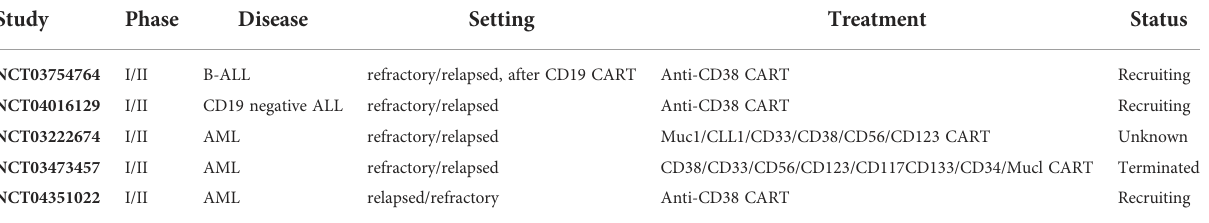
TABLE 4 Clinical trials of CD38 CAR-T cell therapies in AL.